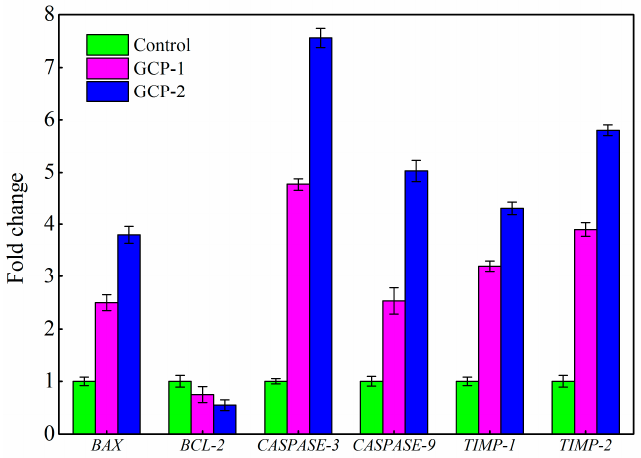
Figure 6. Relative transcription level of apoptosis and metastasis genes before and after treatment with 200 μ g/mL GCP-1 and GCP-2.